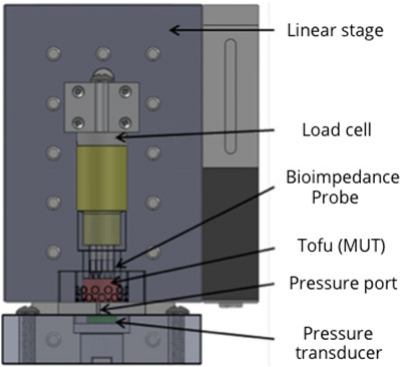
Fig. 3. A graphical representation of the experimental setup with each of the important elements